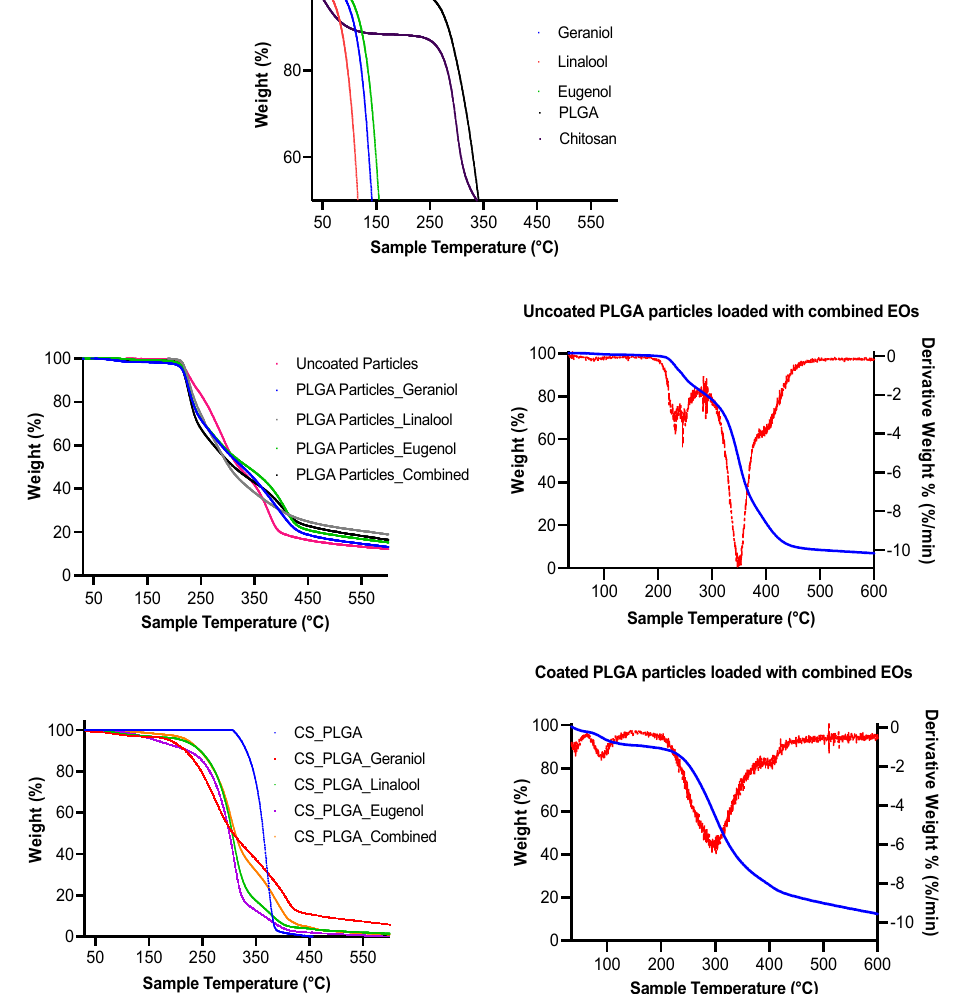
Figure 6. Thermogram of chemicals used to prepare the particles, EO components, plain and loaded PLGA particles (uncoated or coated), and the corresponding derivatives; thermogravimetry (DTG) analysis on the right side.